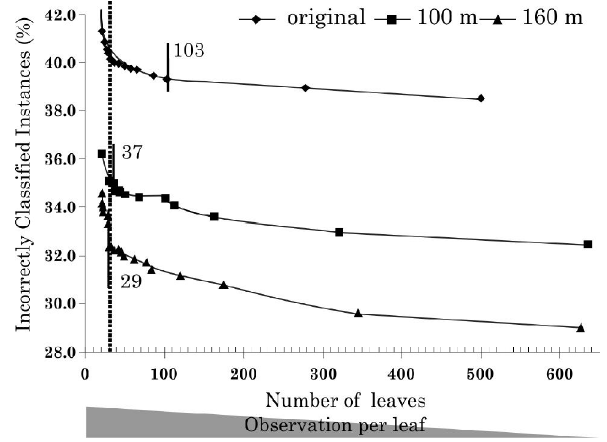
Figure 3. Relationship between the number of leaves and wrongly classified observations per decision tree. Sets of data without displacement (original) and with displacement of 100 and 160 m from the edge of the polygons. The numbers near the vertical bars indicate the minimum number of leaves to ensure that all soil classes would be predicted with that data set. The dashed vertical line indicates that the number of 30 leaves is the limit above which there is a sudden increase in the number of incorrectly classified observations in the three data